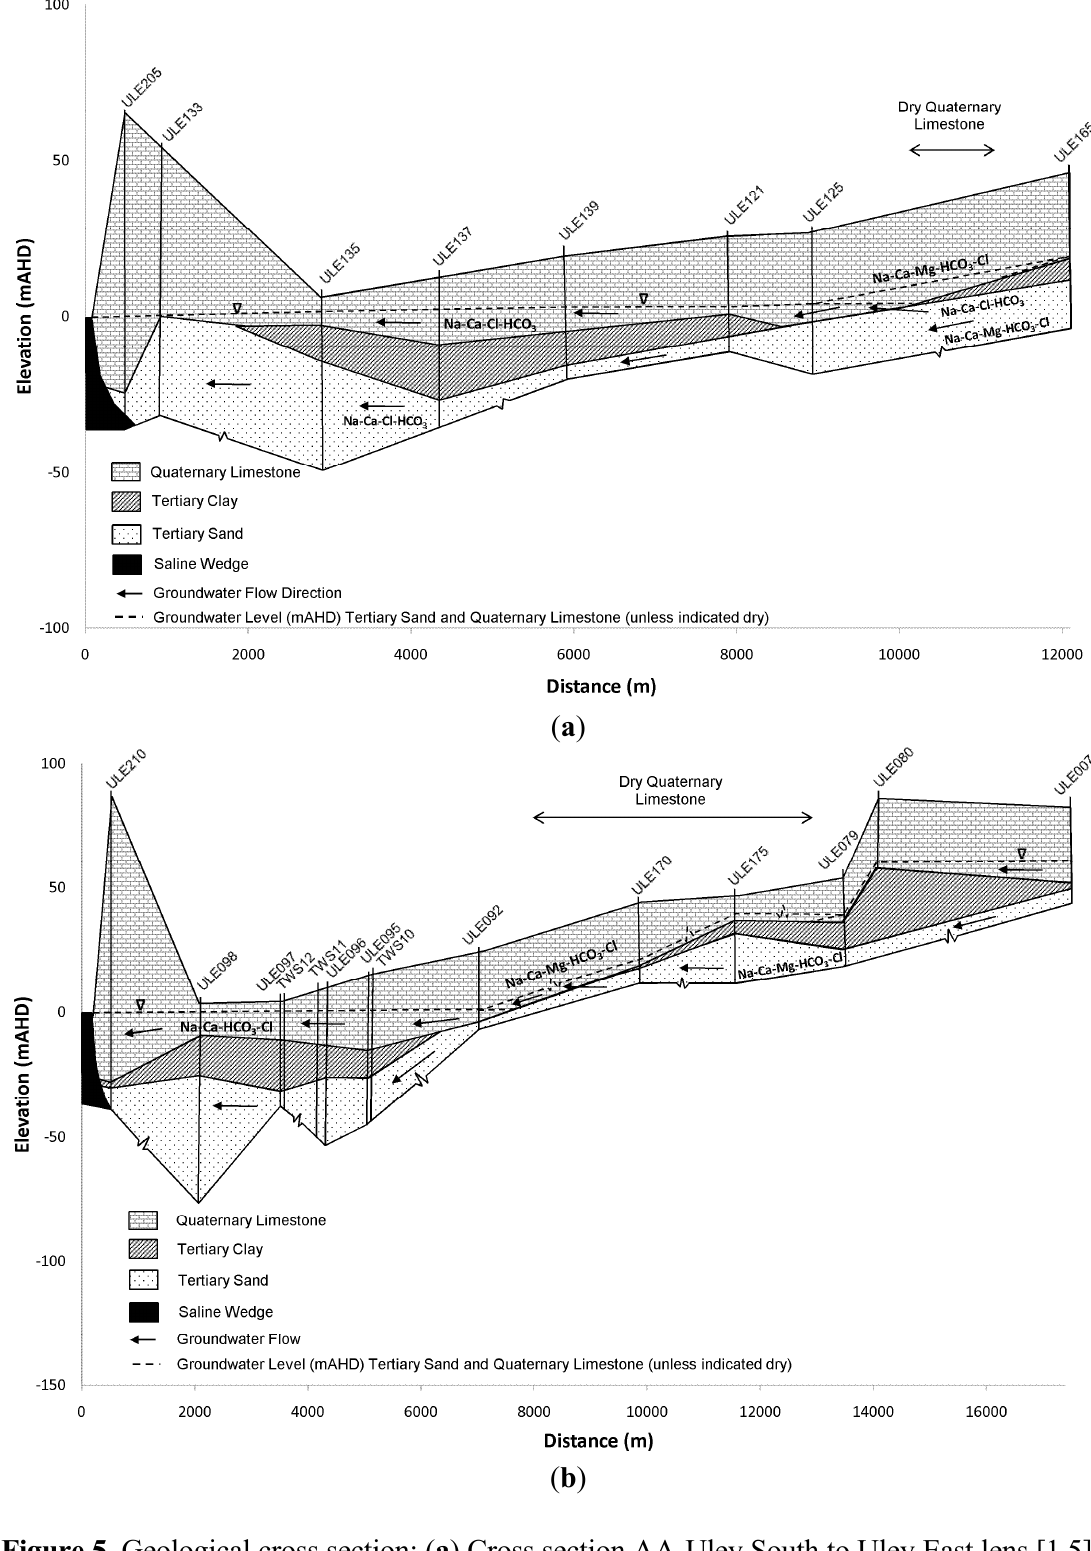
Figure 5. Geological cross section: ( a ) Cross section AA-Uley South to Uley East lens [1,5]; and ( b ) Cross section BB-Uley South to Uley Wanilla